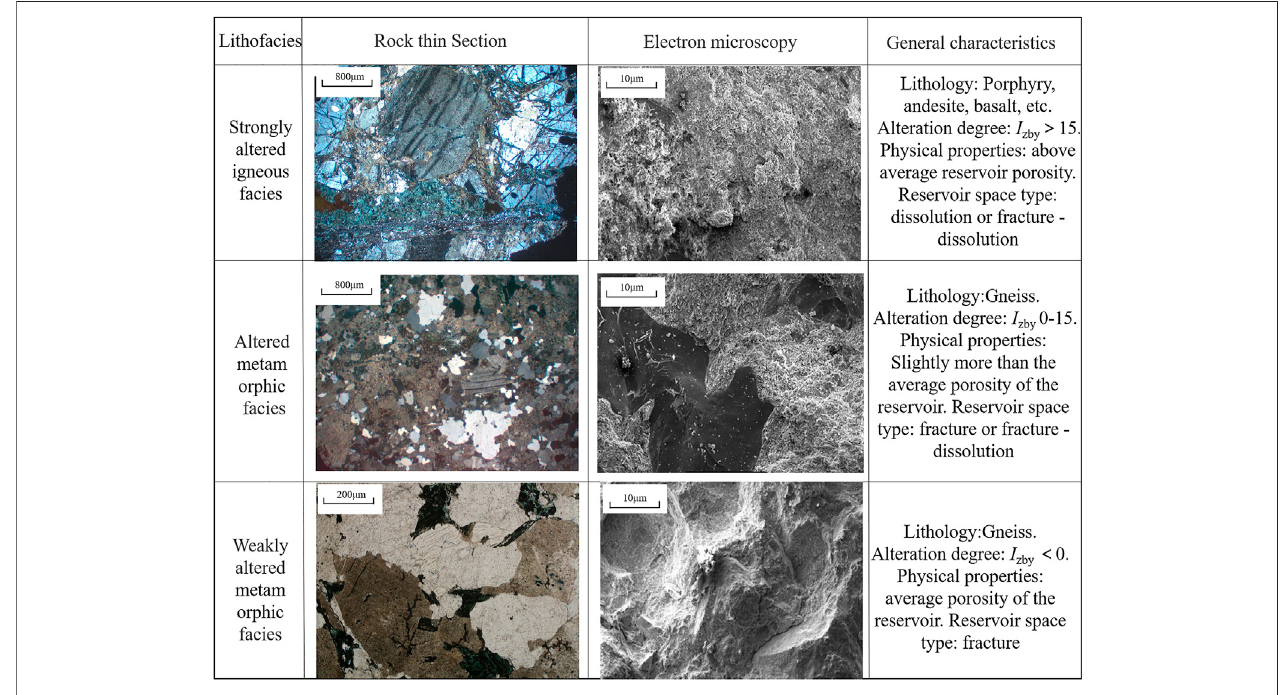
FIGURE 8 | Lithofacies division based on the alteration degree